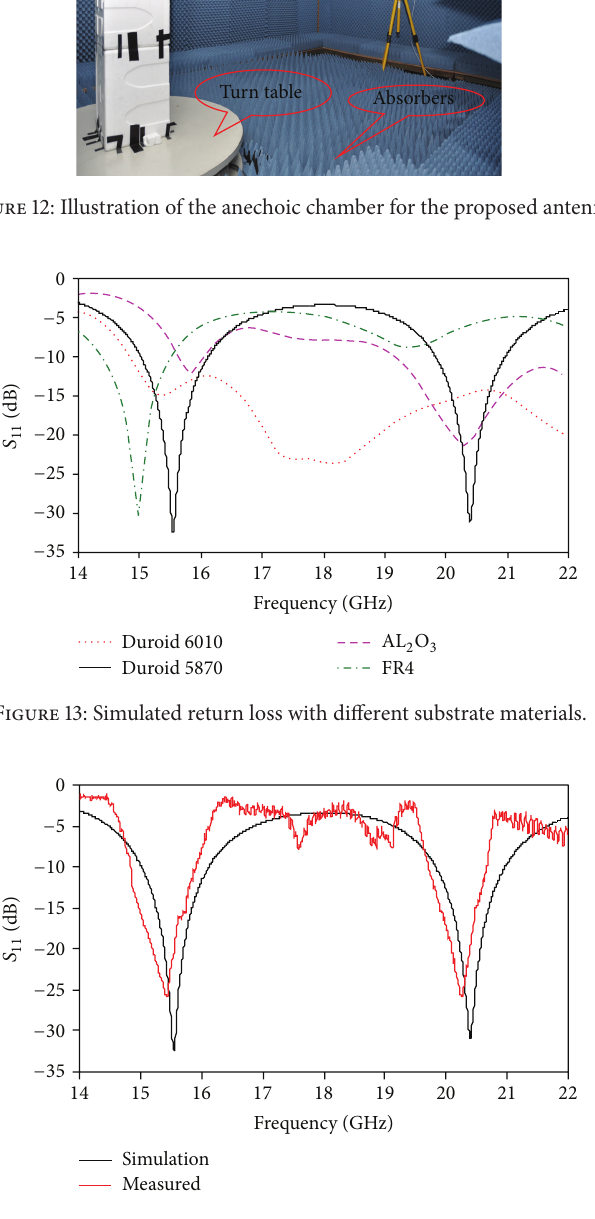
Figure 14: Simulated and measured return losses of the proposed